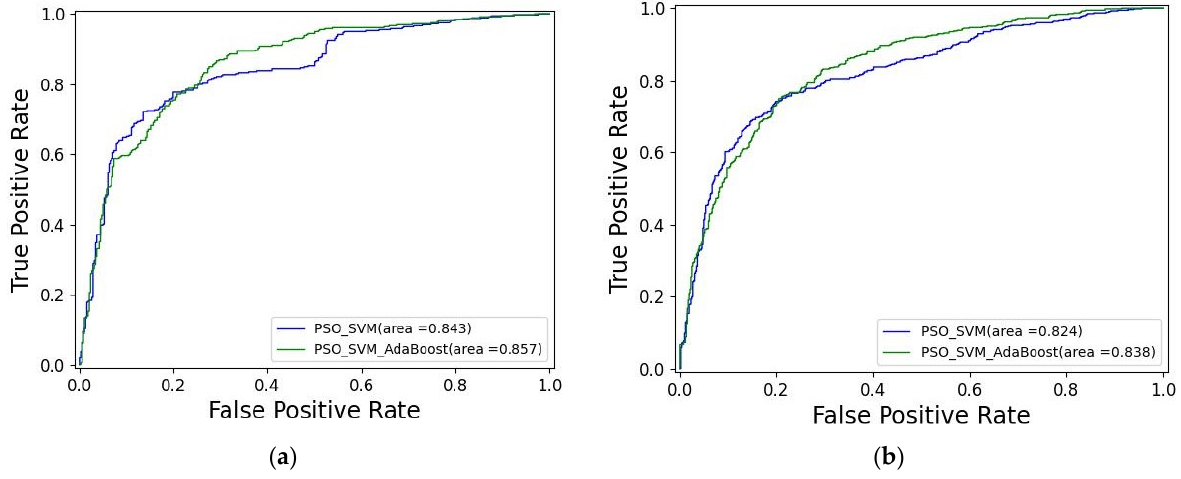
Figure 6. Comparison of ROC curves of the two datasets: ( a ) The ROC curves of the two methods after sampling HIV-1 protease; ( b ) The ROC curves of the two methods after sampling Src kinase.